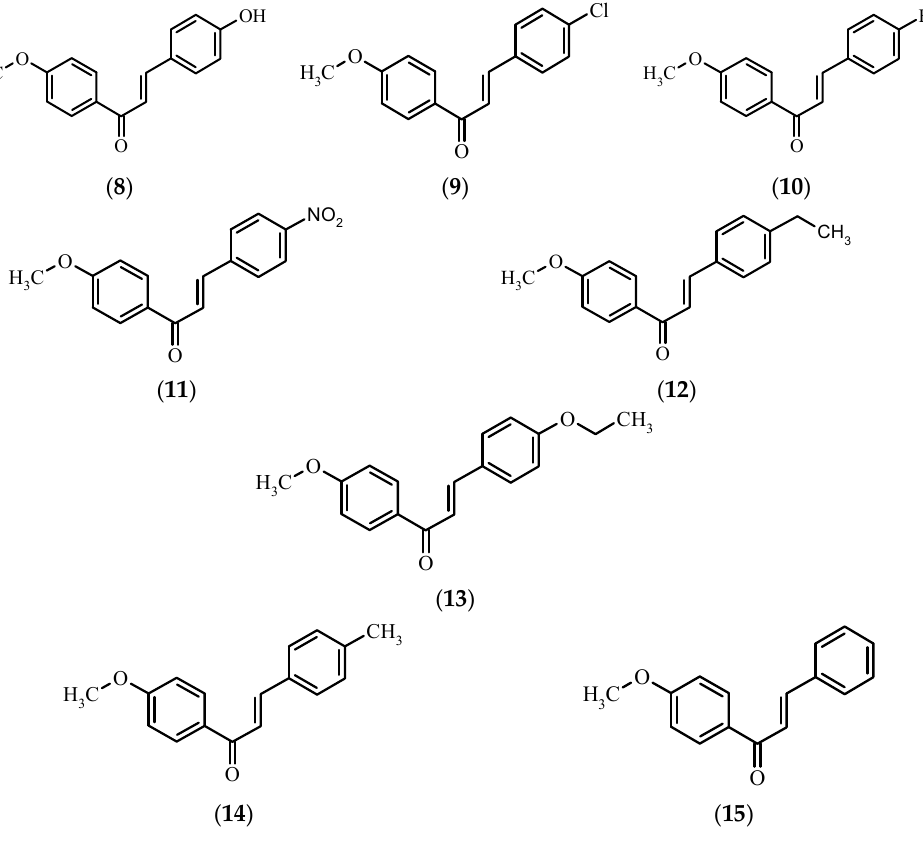
Figure 2. Chemical structure of 4 ′ -methoxychalcones 8 – 15 .